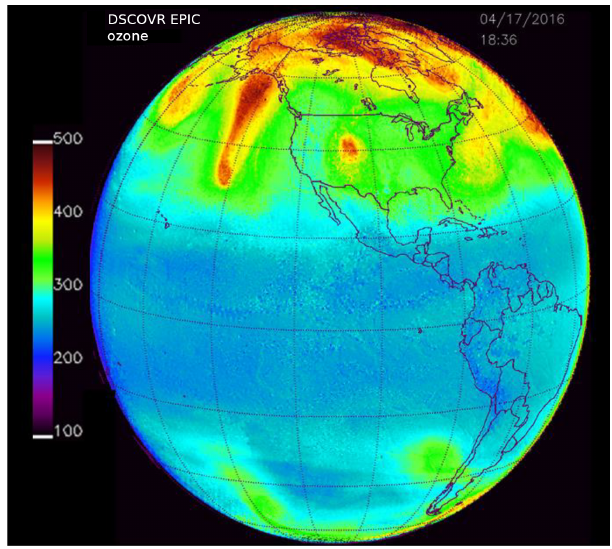
Figure 14. Global image of ozone field for Figs. 15 and 16 for 17 April 2016 at 18:36